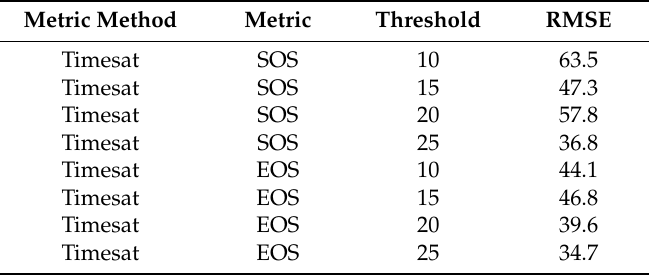
Table 3. Summary of root mean square error (RMSE) as the absolute difference in the number of days for comparisons of phenocam landscape GCC with SOS and EOS dates derived from 250-m NDVI. SOS and EOS dates were derived using Timesat with four seasonal amplitude